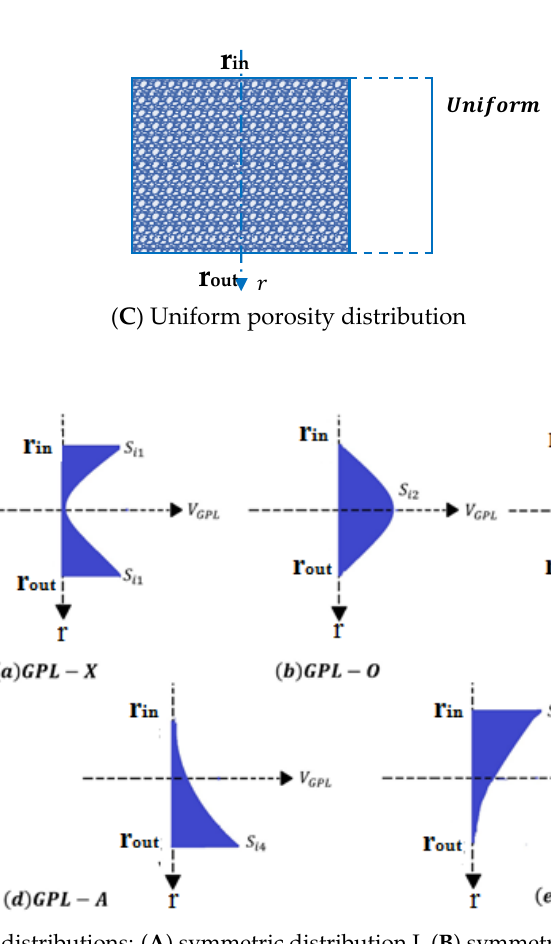
Figure 2. GPL distributions: ( A ) symmetric distribution I, ( B ) symmetric distribution II and ( C ) uniform distribution and patterns of porosities: ( a ) GPL-X, ( b ) GPL-O, ( c ) GPL-UD, ( d ) GPL-A, ( e ) GPL-V.